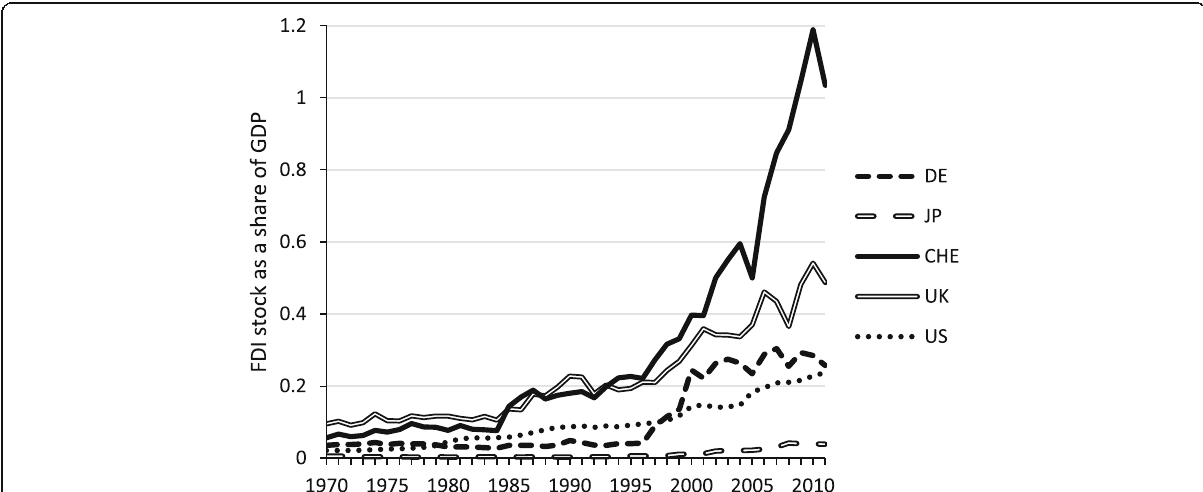
Fig. 7 Stock of FDI as a share of GDP. Sample: 1970 – 2011, Source: External Wealth of Nations, Lane and Milesi-Ferretti (2007), updated